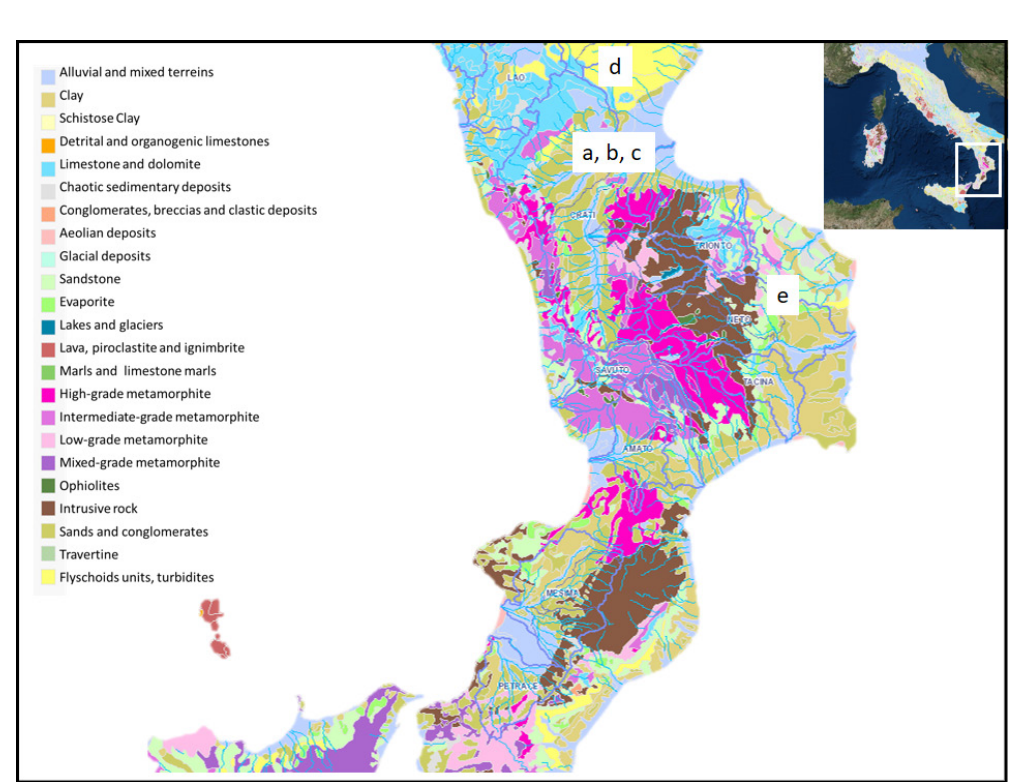
Fig. 1. Location map of the collection sites in Calabria, and lithological units. a . Grotta superiore di Sant’Angelo. b . Grotta Vucco Ucciardo. c . Grotta dello Scoglio. d . Grotta del Banco di ferro. e . Grave Grubbo.